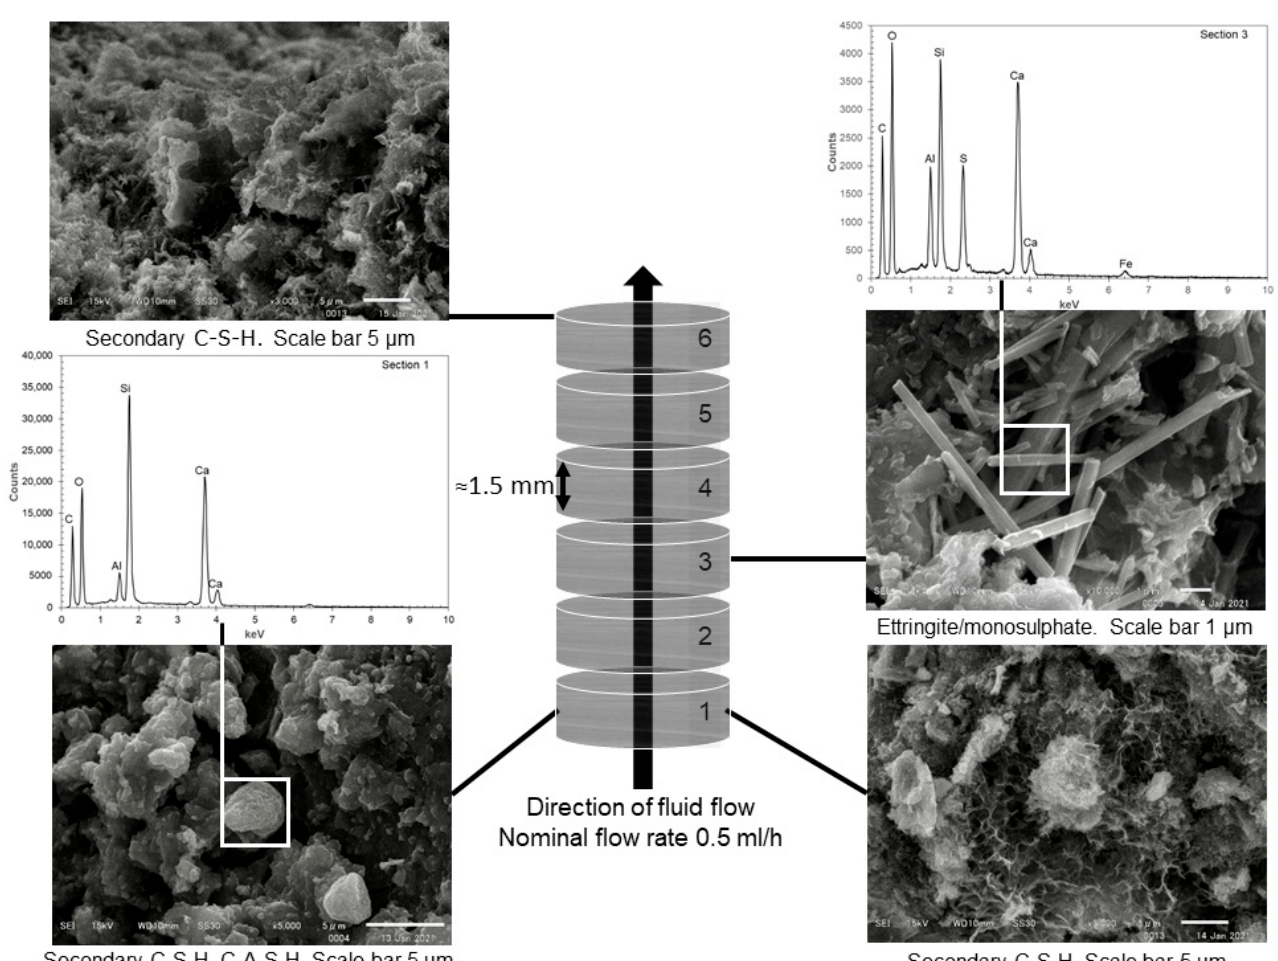
Figure 6. Summary of mineralogy of Horonobe mudstone with ‘young’ OPC (Na-K-Ca-OH) and then ‘evolved OPC leachate (Ca(OH) 2 ) (SFC-2). All SEM photos are secondary electron (SE) images. The white square in the SEM images from sections 1 and 3 indicate the areas used for SEM-EDS analysis of the secondary phases.